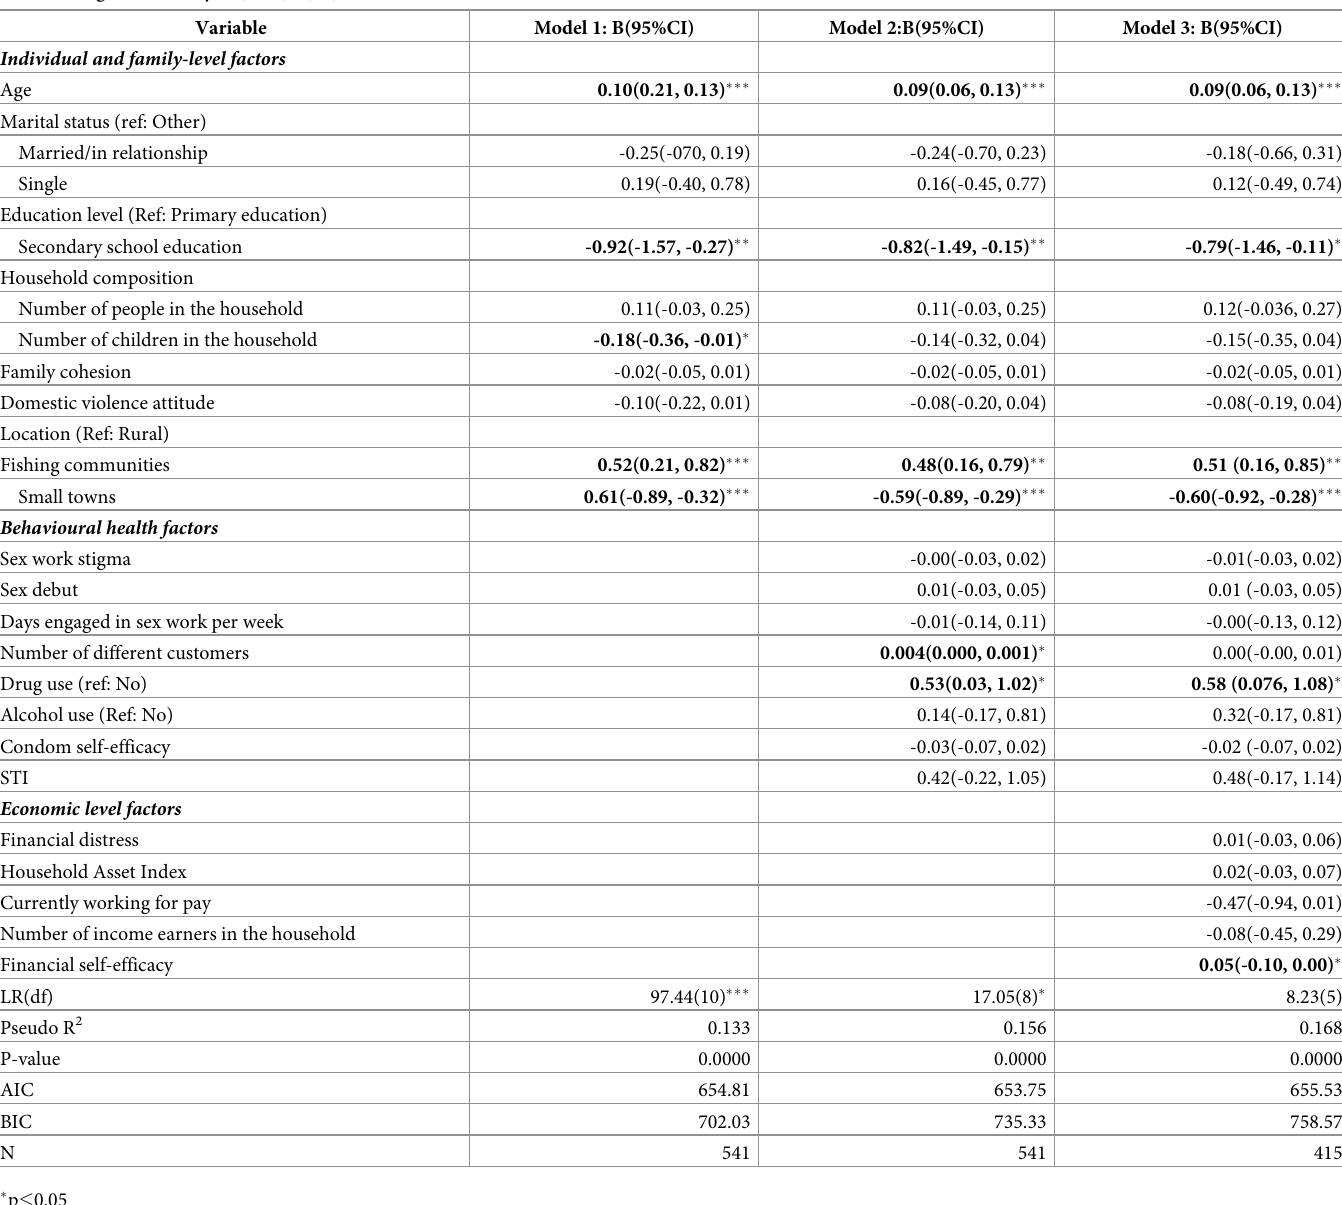
Table 2. Regression analysis (HIV)